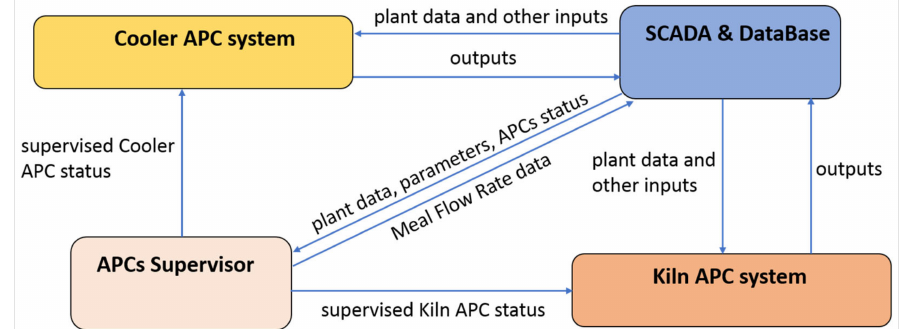
Figure 4. APCs cooperation